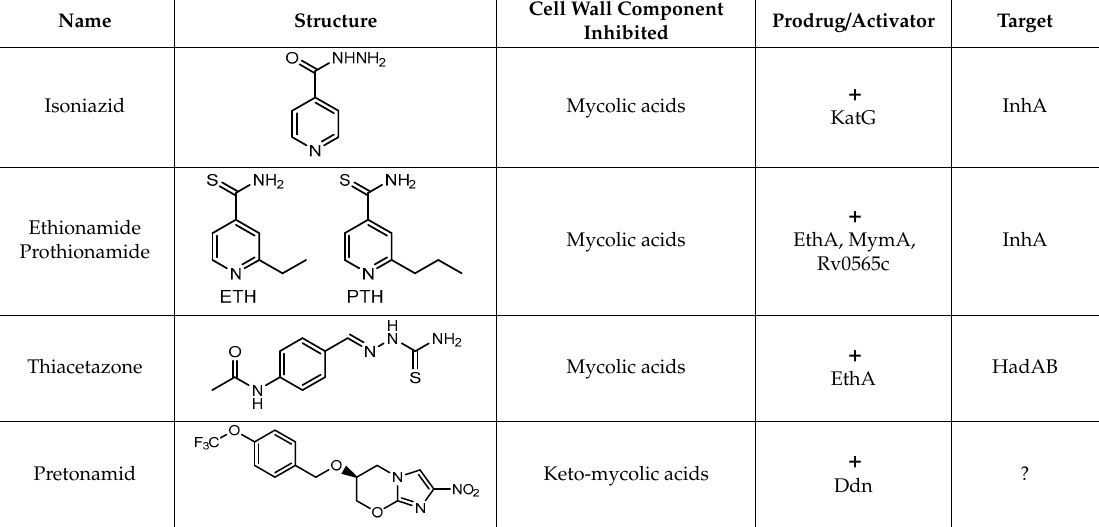
Table 1. TB drugs targeting the mycobacterial cell wall.